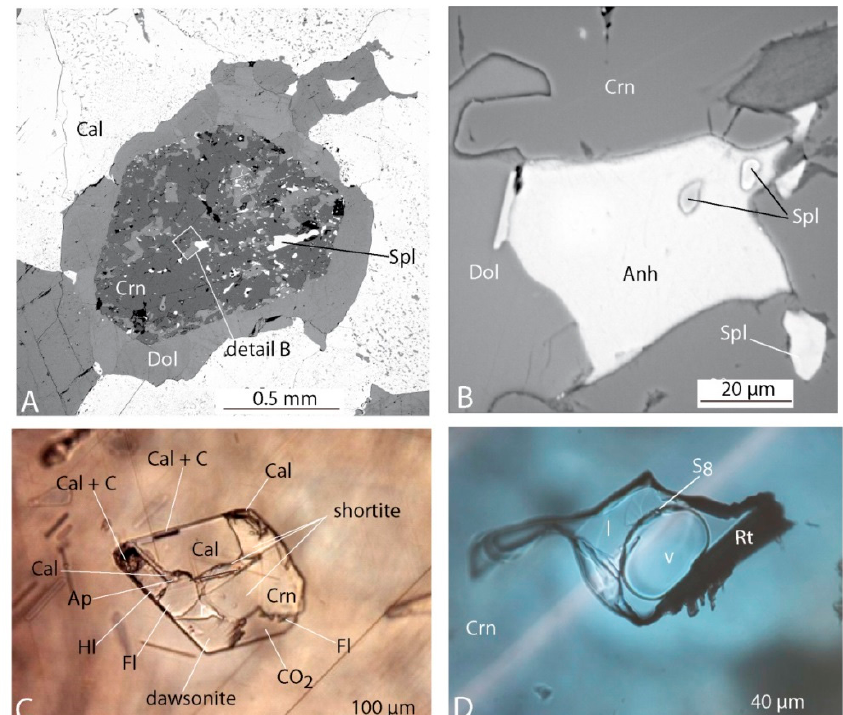
Figure 35. Mineral assemblage and fluid inclusions in ruby-bearing marble deposits from Central and South-East Asia. ( A ) Association ruby (Crn), dolomite (Dol), calcite (Cal), and spinel (Spl) illustrating the formation of ruby by the chemical reaction: spinel + calcite + CO 2 ↔ corundum + dolomite, Hunza valley (Pakistan); ( B ) inset of Figure 35A (detail B) showing the presence of anhydrite (Anh) with spinel inclusions (Spl). Spinel is a pre-ruby phase that has high Cr (up to 19 wt % Cr 2 O 3 ) and Zn (up to 10 wt % ZnO) contents; ( C ) primary polycrystalline fluid inclusion cavity in ruby containing different solids (molten salts), which are mixtures of carbonates, with Ca-Na-Al cations such as calcite (Cal), dawsonite (Dw), shortite, and apatite (Ap), fluorite (Fl), halite (Hl), graphite (C), and a CO 2 -H 2 S-bearing fluid phase (CO 2 ), Mogok, Myanmar; and ( D ) three phase fluid inclusions with CO 2 and H 2 S liquid (l) + vapor (V) phases and native sulphur (S 8 ) trapped by ruby in a rutile (Rt)-bearing cavity, Mong Hsu deposit Myanmar. Photos A and B: Virginie Garnier, [65]; Photos C and D: Gaston Giuliani,